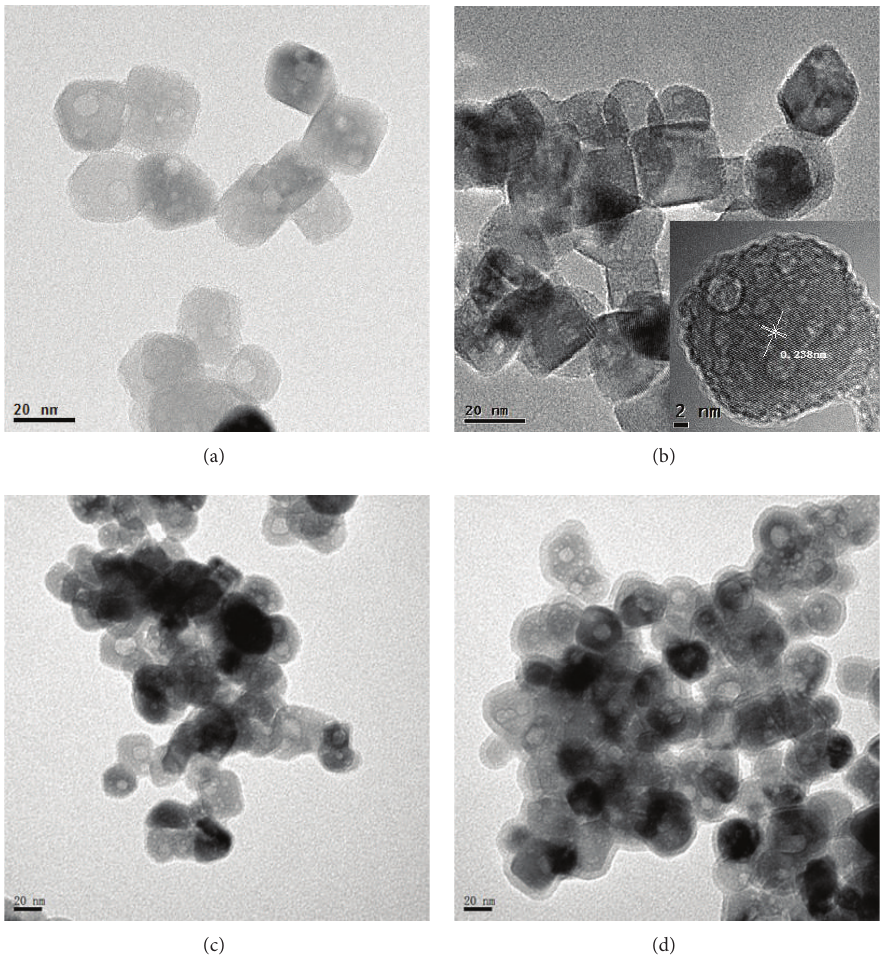
Figure 2: TEM pictures of all samples ((a) S1-500, (b) S2-500, (c) S3-500, and (d) S4-500).